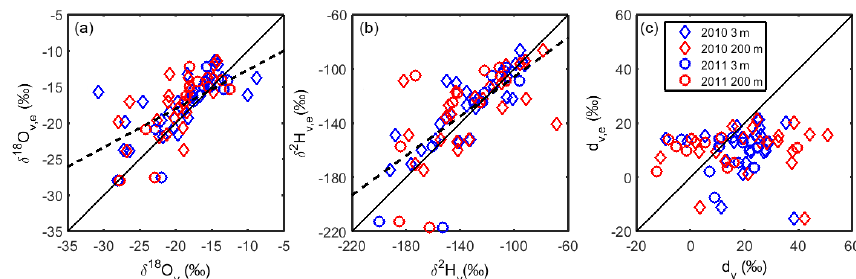
Figure 3. Comparison of (a) oxygen, (b) hydrogen, and (c) deuterium excess isotope composition of water vapor measured at 3 and 185m compared to the theoretical values for water vapor in isotope equilibrium with precipitation (falling raindrops) during the 2010–2011 growing season. The solid lines show the 1:1 relation. The dashed lines show the best-fit linear